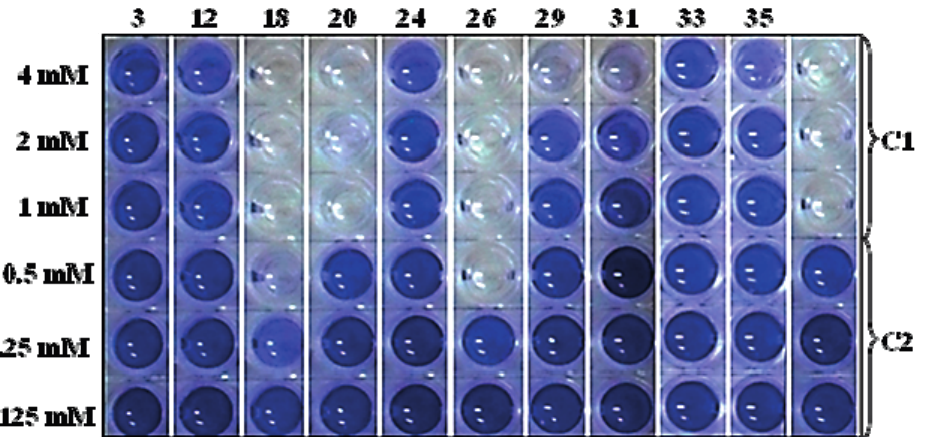
Figure 3. Anti-QS effects of selected compounds evaluated for violacein inhibition in a C. violaceum CV026 quantification assay. Columns: ( 3 ) furan-2-carboxylic acid, ( 12 )